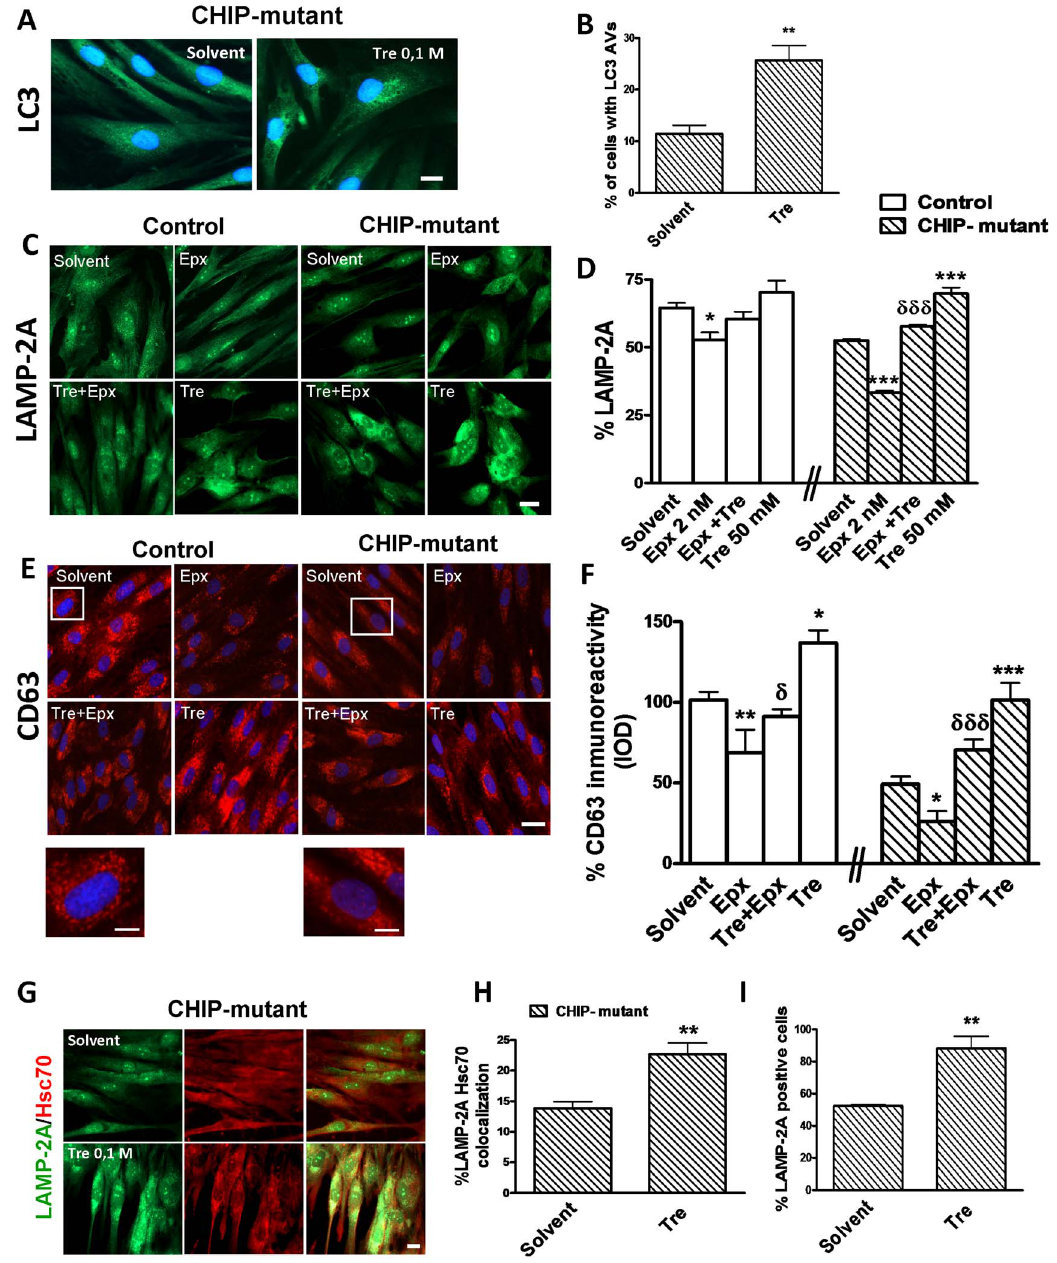
Figure 5. Trehalose increases autophagy activity in CHIP-mutant human fibroblasts. After 5 DIV, fibroblasts were pre-treated with trehalose (50 or 100 mM) for 15 minutes followed by addition of epoxomicin or solvent for another 24 h. A ) LC3 staining (green) and nuclei (Hoescht, blue) immunofluorescence in CHIP-mutant fibroblast treated with trehalose (100 mM) and their quantification B ) in percentage of cells with more than 50 autophagic vesicles (Scale bar =20 m m). C ) Representative microphotographs of Lysosomal-associated membrane protein, LAMP-2A, present in lysosomes and endosomes, (Scale bar =20 m m) and D ) quantification in percentage of cells with LAMP-2A positive vesicle distribution in the perinuclear region, around the nucleus. E ) Images of fibroblasts expressing CD63, as a late endo/lysosomal marker (Scale bar =30 m m) and F ) quantification in percentage of optical intensity for CD63 inmunoreactivity. The insets show boxed regions at higher magnification (Scale bar =15 m m). G ) Immunofluorescence for HSC70 and LAMP-2A in CHIP-mutant cultures treated with trehalose 100 mM for 48 h (Scale bar =20 m m) and H ) percentage of co-localization LAMP-2A/HSC70 positive cells. I ) Percentage of LAMP-2A positive cells. Data of the control and CHIP-mutant groups were analyzed independently, no inter-group statistical analysis was performed. Data are expressed as the mean 6 SEM. Values in 5B, 5D, 5H and 5I are the mean 6 S.E.M. of two experiments with six cover slips, from 150 to 250 cells of every group were counted. In 5F, in CD63 immunostaining data are the mean of 4 independent dishes of cells for 2 control individuals (n=2), in the CHIP-mutant group 6 independent dishes of cells of the only patient (pseudo-replicates, n=6). Statistical analysis was performed by Student’s t-test. *p , 0.05, **p , 0.01, ***p , 0.001 vs solvents; d p , 0.05, ddd p , 0.001 trehalose + epoxomicin vs epoxomicin treated cultures.